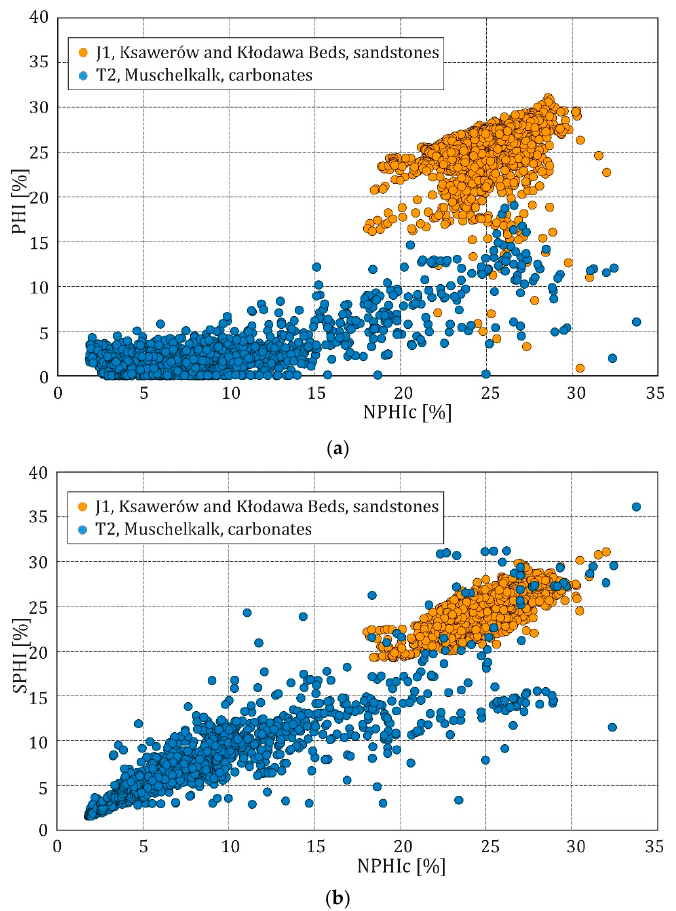
Figure 7. ( a ) Total porosity, PHI vs. neutron porosity after all corrections, NPHIc, GT ‐ 1 borehole; PHI of J1 sandstones reveals higher values, scattering of data is due to shaliness, PHI of T2 carbonates is generally lower than sandstones, scattering of data is related to intergranular porosity, fissures and fractures of carbonates. ( b ) GT ‐ 1; Sonic porosity, SPHI vs. neutron porosity after all corrections, NPHIc; SPHI of J1 sandstones is higher than of carbonates; data scattering is more distinctly visible in carbonates than in sandstones. Primary lithology recognition was also possible based on other logs. After processing results of Wave Sonic log with dipole source in GT ‐ 1 borehole slowness of elastic P ‐ and S ‐ waves (DTP and DTS) were determined in ‐ depth section 2335.0–2752.0 m comprising the Rhaetian and Keuper formations (Figure 8a,b). In Figure 8a two branches are ob ‐ served—one in more sandy formation and the second—in more shaly one. The position of the branches is determined by DTP and DTS values. GR histograms (added in Figure 8c) distinctly differentiate between more shaly Keuper and more sandy Rhaetian for ‐